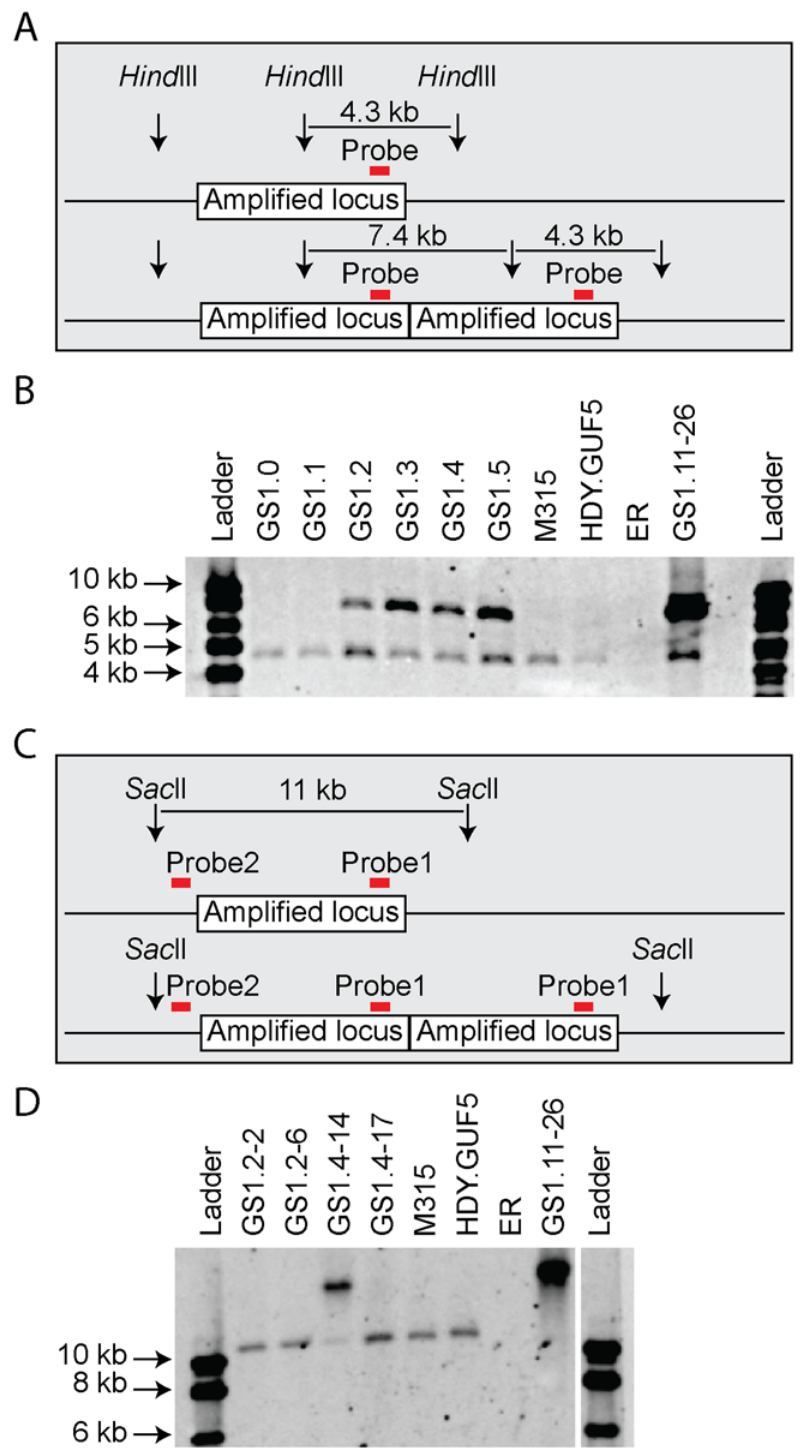
Fig 4. Evaluation of the amplified XylA -locus by Southern blot analysis. (A) and (C) show a schematic representation of the amplified XylA -locus in GS1.11 – 26. Vertical arrows represent cutting sites of the restriction enzymes; red horizontal bar indicates the locus of the unique site for probe hybridization. The amplified locus is shown once in the upper part and twice in the lower part. (B) Image of the Southern blot analysis after Hind III digestion. Two bands of expected size 4.3 kb and 7.4 kb were detected in GS1.11 –